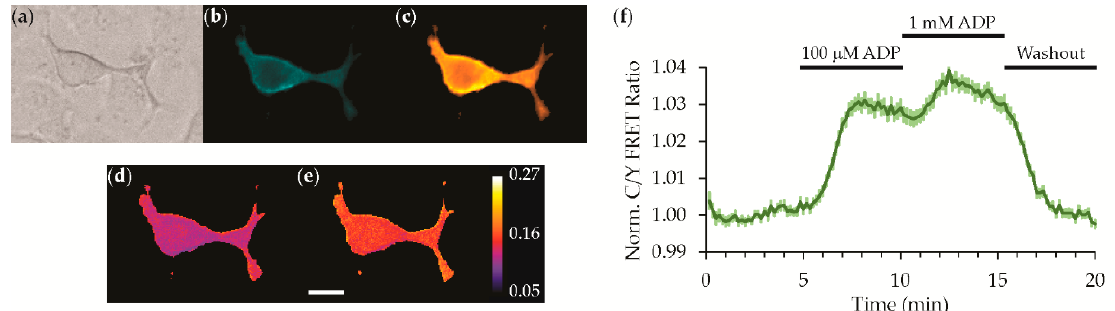
Figure 9. The ADPrime sensor responds to extracellular ADP. Widefield microscopy shows an example of a sensor expressing HEK293 cell. Panels show individual ( a ) differential interference and ( c ) YFP channels as well as C / Y ratio images ( d ) before and ( e ) after ADP wash-in. The false color contrast, ( b ) CFP, and ( c ) YFP channels as well as C/Y ratio images ( d ) before and ( e ) after ADP calibration bar is for the raw mTFP / FRET ratio. Scale bar = 50 µ m. ( f ) Time course of ADPrime response wash-in. The false color calibration bar is for the raw mTFP/FRET ratio. Scale bar = 50 µm. ( f ) Time on live cells, mean ± 95% CI (77 cells, 11 course of ADPrime response on live cells, mean ± 95% CI (77 cells, 11 experiments).